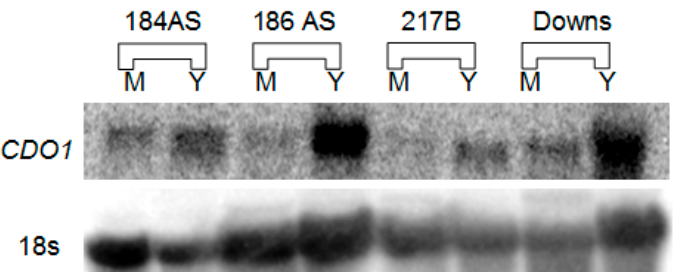
Figure 1. Northern blot analysis of CDO1 (top) probed with Hc full length 32 P- CDO1 compared to 18s RNA: competimer control (bottom) stripped then probed with 18s 32 P-rDNA. M, mold morphotype; Y, yeast morphotype.